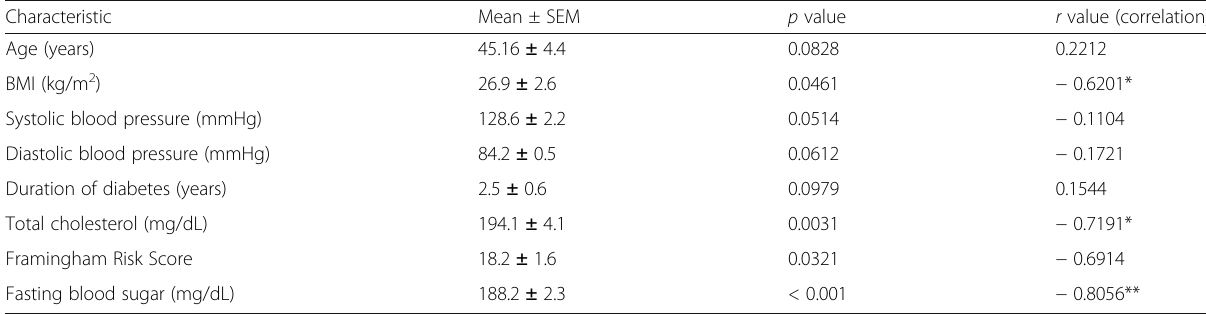
Table 3 Correlation of variables with vitamin C